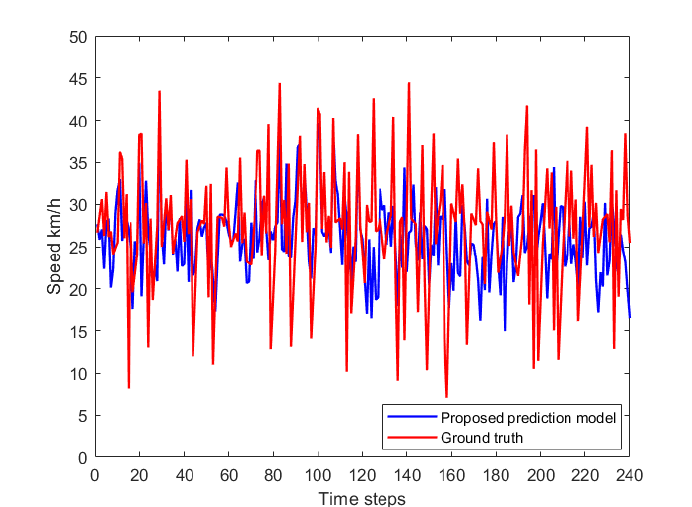
Figure 8. The comparison cavers under 60 min forecasting interval.